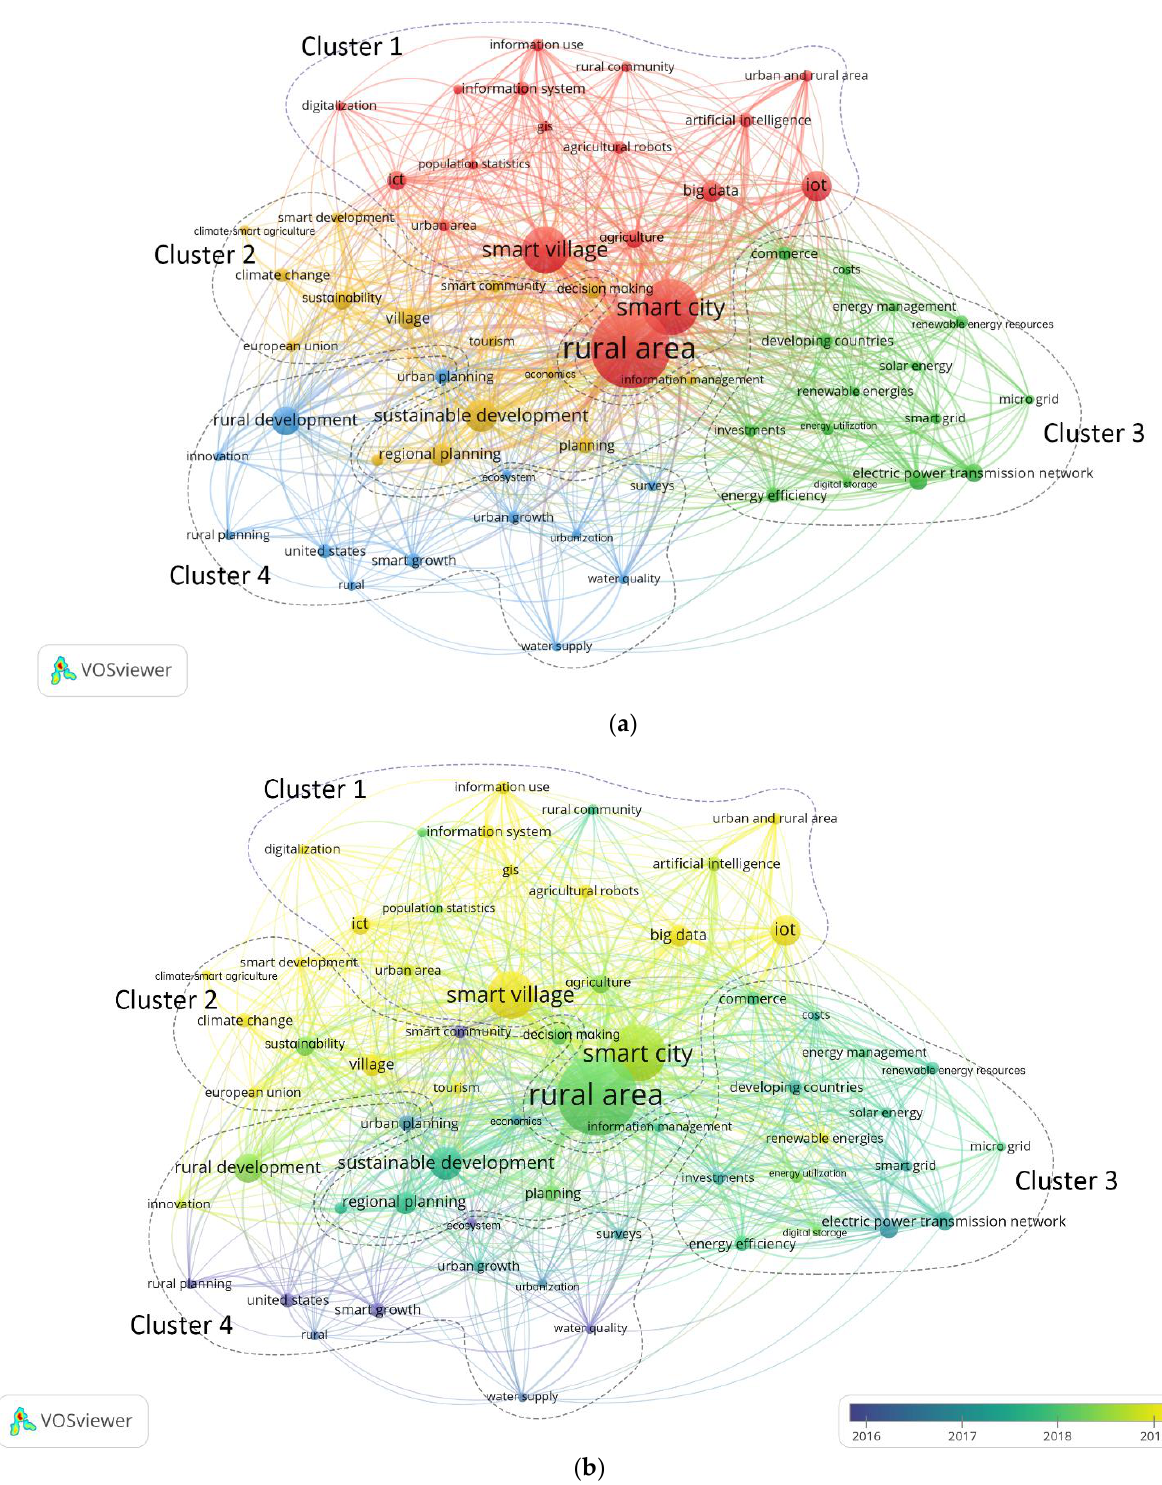
Figure 6. Keyword co-occurrence network. ( a ) Network visualization view; ( b ) Overlay visualization view. Minimum occurrence frequency, 8; nodes, 61; clusters, 4; links, 795; total link strength, 2352.